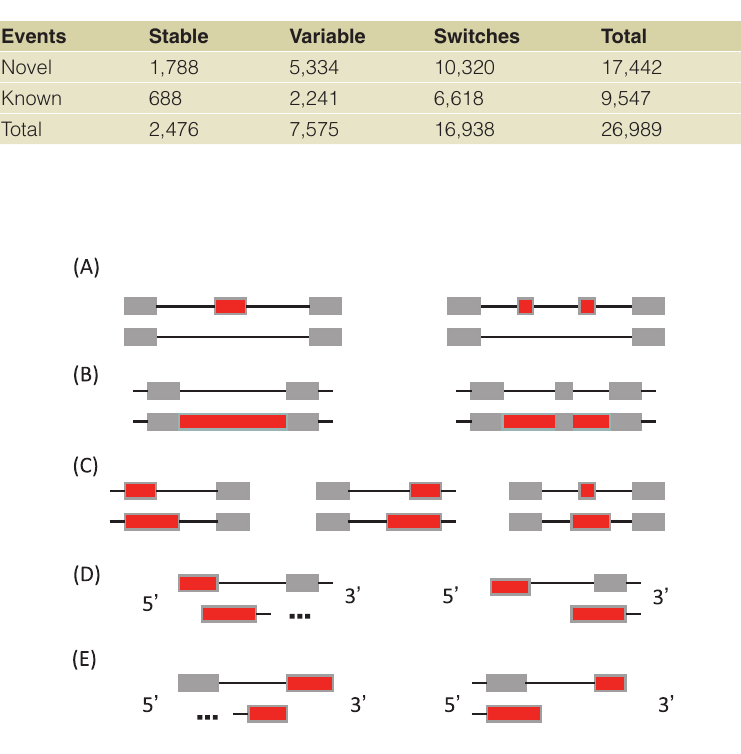
Figure S14. Classes of alternative splicing events detected by ASprofile by pairwise transcript comparisons. ( A ) Exon skipping (SKIP) and cassette exons (MSKIP); ( B ) retention of single (IR) and multiple (MIR) introns; ( C ) alternative exon ends (AE); ( D ) alternative transcription start site (TSS); and ( E ) alternative transcription termination site (TTS). Alternatively spliced features are shown in